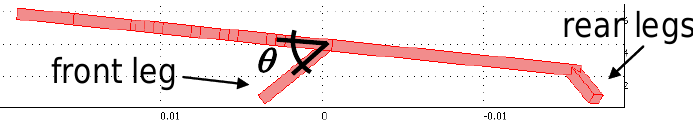
Figure 2. Side view of model in COMSOL illustrating the larger front leg and shorter rear legs. The main body of the robot is angled upward from the ground. The front leg angle,  , is shown in the